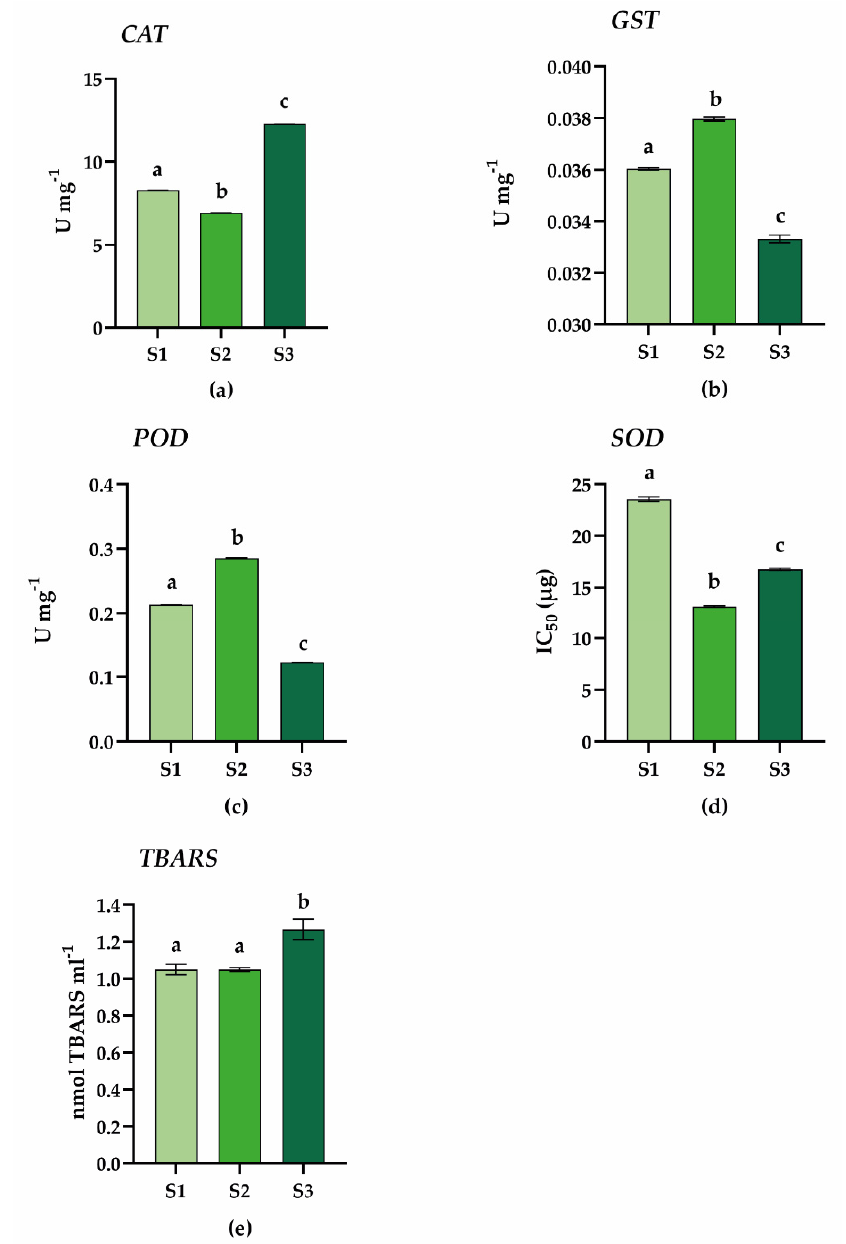
Figure 6. Antioxidant enzyme activities and TBARS content in C. quitensis leaves collected at the three sites S1, S2, and S3 (x-axes). ( a ) Catalase (CAT); ( b ) glutathione S-transferase (GST); ( c ) guaiacol peroxidase (POD); ( d ) superoxide dismutase (SOD); ( e ) TBARS content. Data represent the mean ± SD of three biological replicates. For all enzymatic assays, a statistically significant difference was found between all sites ( p < 0.0001). As for TBARS, a statistically significant difference was found only between S1 vs. S3 and S2 vs. S3 ( p < 0.0001). Statistic test: one-way ANOVA, Tukey’s multiple comparisons. The letters indicate significant differences between the samples.